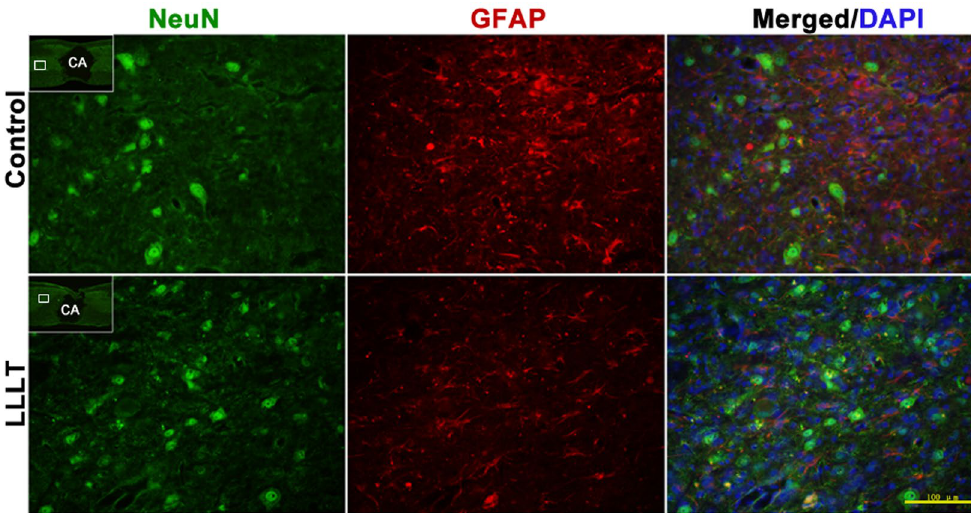
Figure 6. Neurons and astrocytes coexist in the para injury site. Representative immunostaining images of neurons (NeuN, green signal) and astrocytes (GFAP, red signal). Images were obtained from para injury site. The images are enlarged pictures of the small quadrilateral region in the sections. NeuN, neuronal nuclei. GFAP, glial fibrillary acidic protein. CA, cavity. Bar = 100 μ m.